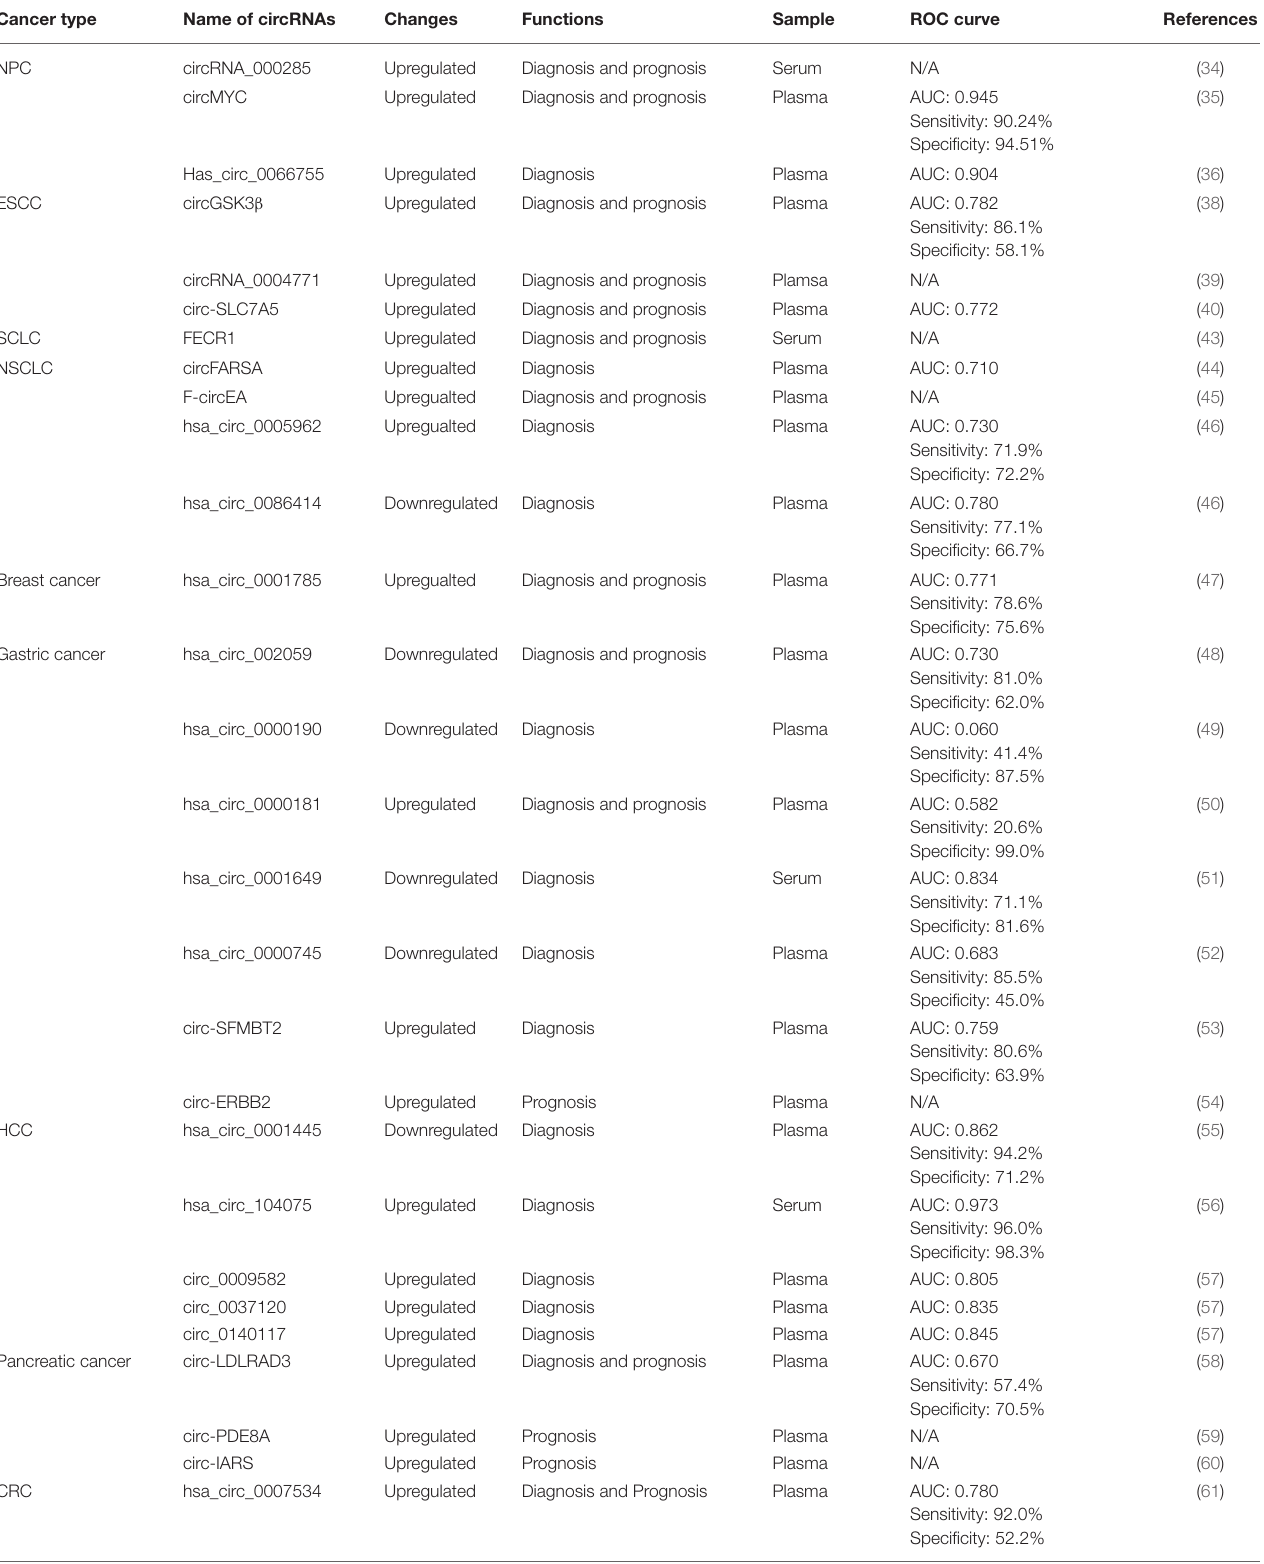
TABLE 1 | Circulating circRNAs in different types of cancer. Cancer